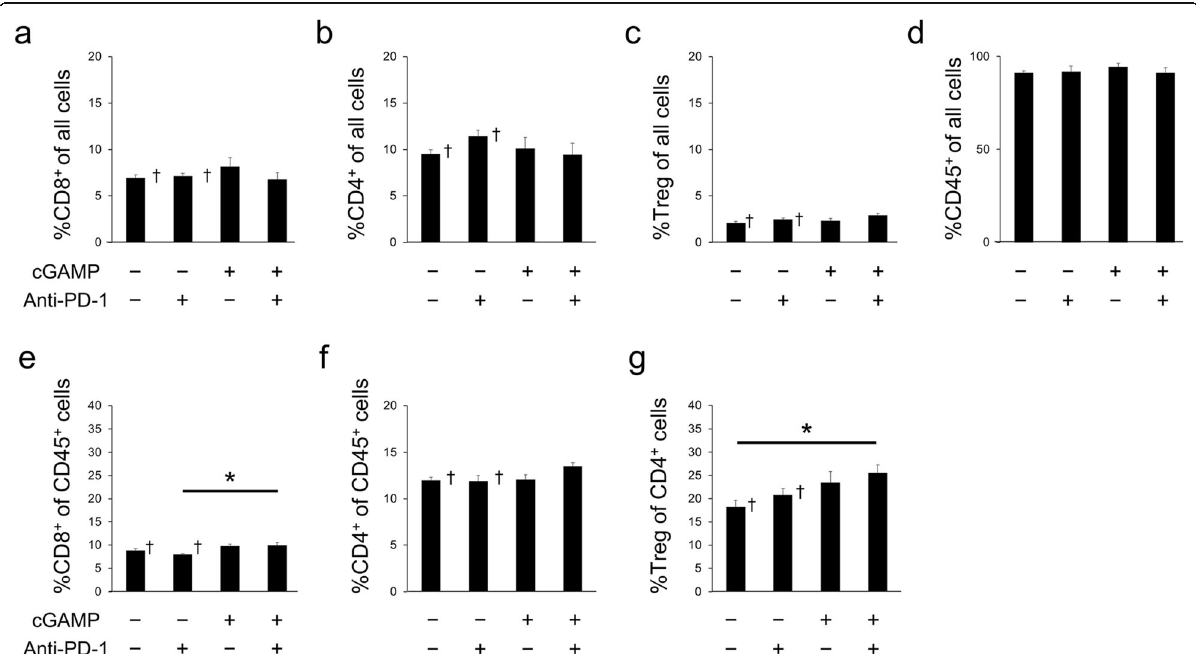
Fig. 4 Flow-cytometry analysis of immune cell populations in spleens of the cGAMP-injected B16F10 model. Percentage of CD8 + cells ( a ), CD4 + cells ( b ), Foxp3 + cells (Treg, c ), and CD45 + cells ( d ) in all cells in spleens on day 7 ( n = 5 – 7). Percentage of CD8 + cells ( e ) and CD4 + cells ( f ) of CD45 + cells in spleens on day 7 ( n = 5 – 7). Percentage of Foxp3 + cells (Treg, g ) of CD4 + cells in spleens on day 7 ( n = 5 – 7). Data of the non- treatment group and anti-PD-1 treated group were quoted from [11]. Data represent the mean ± SEM; * p < 0.05; † Adapted from